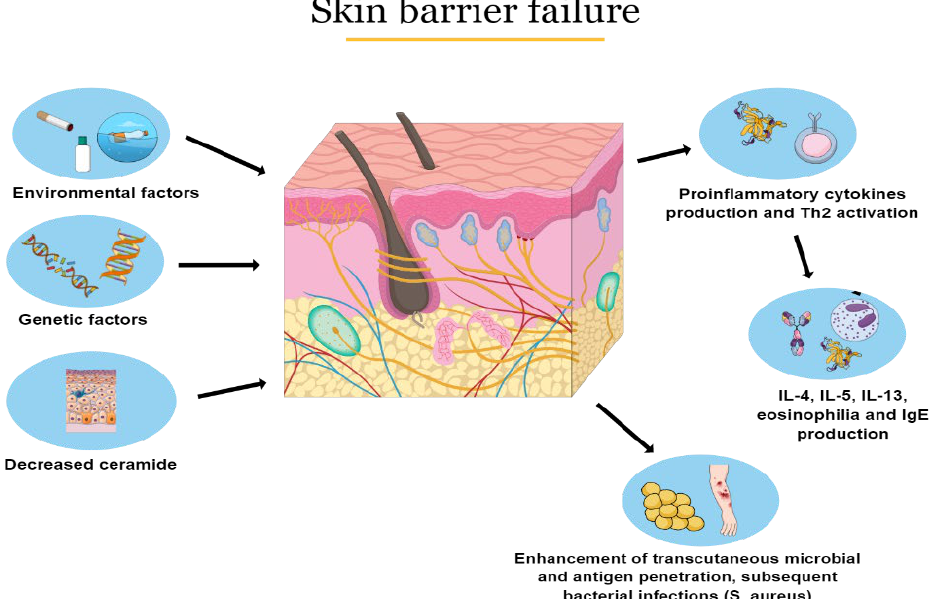
Figure 1. Pathophysiology of Atopic Dermatitis.